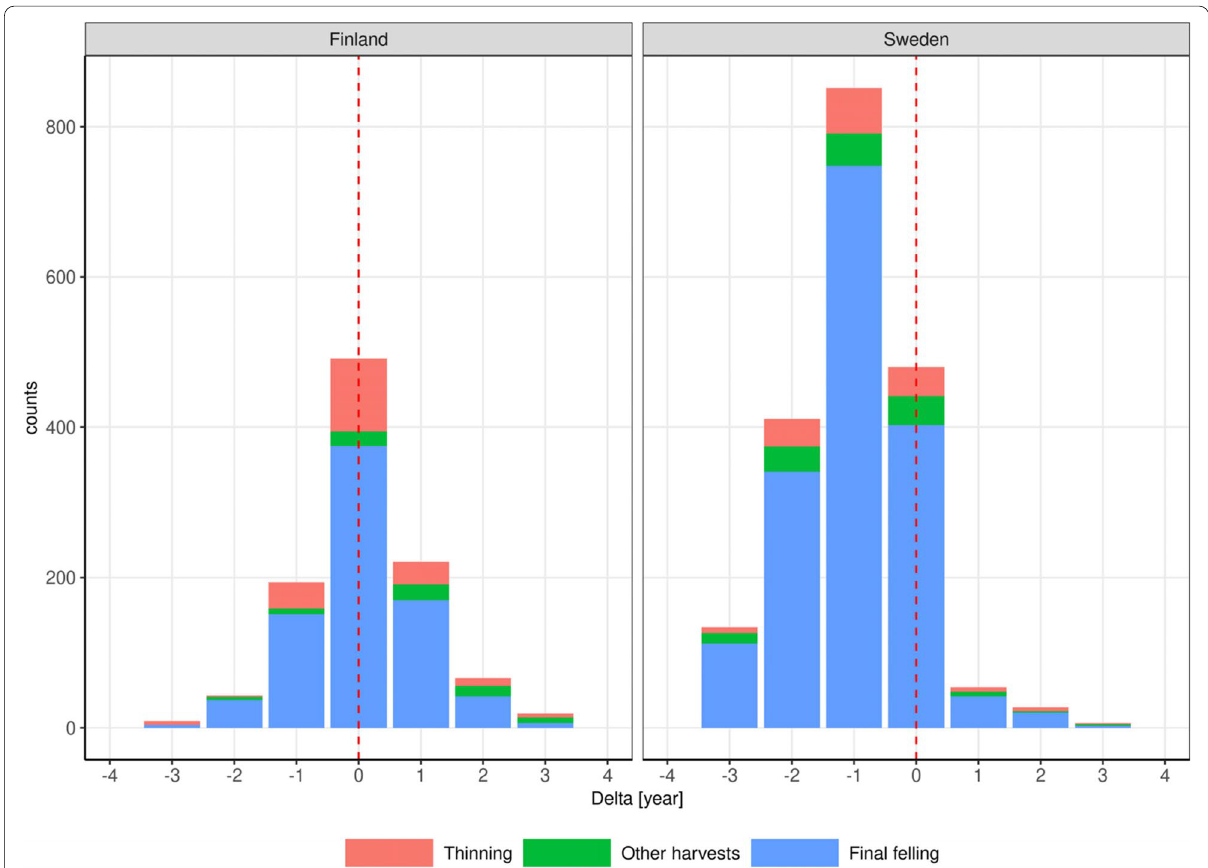
Fig. 2 Histogram of temporal mismatch between GFC and NFIs attribution of forest harvest. Delta is the difference between the year of measurement of the NFIs plot and the year of change by